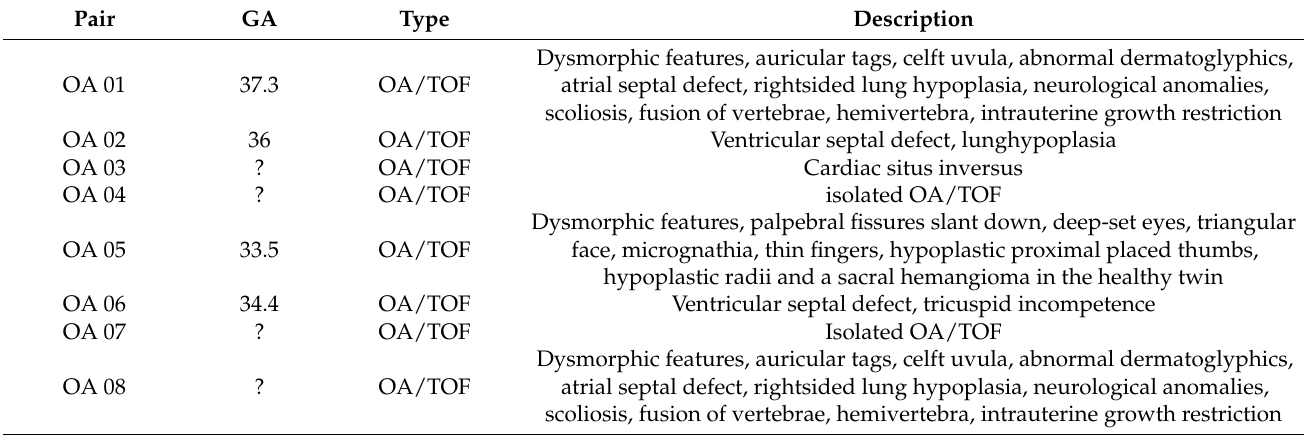
Table 2. Phenotype description of discordant monozygotic twins. Numbering and phenotypical descriptions are kept consistent [128]. GA; Gestational Age